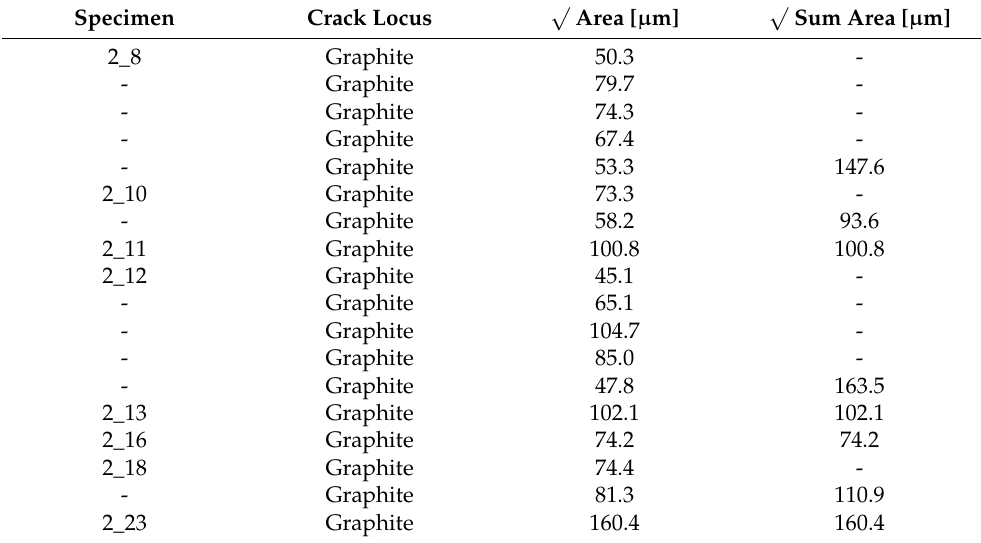
Table A2. Crack locus area sizes alloy